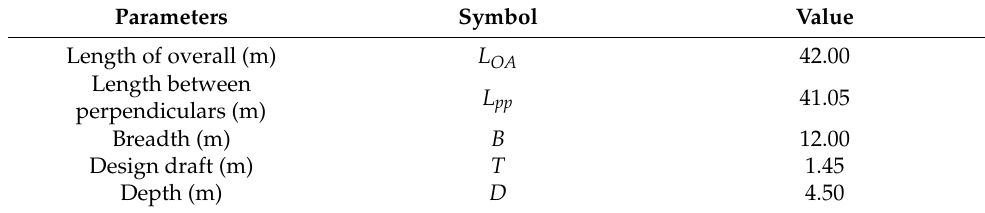
Table 1. Principal dimension of the USV.